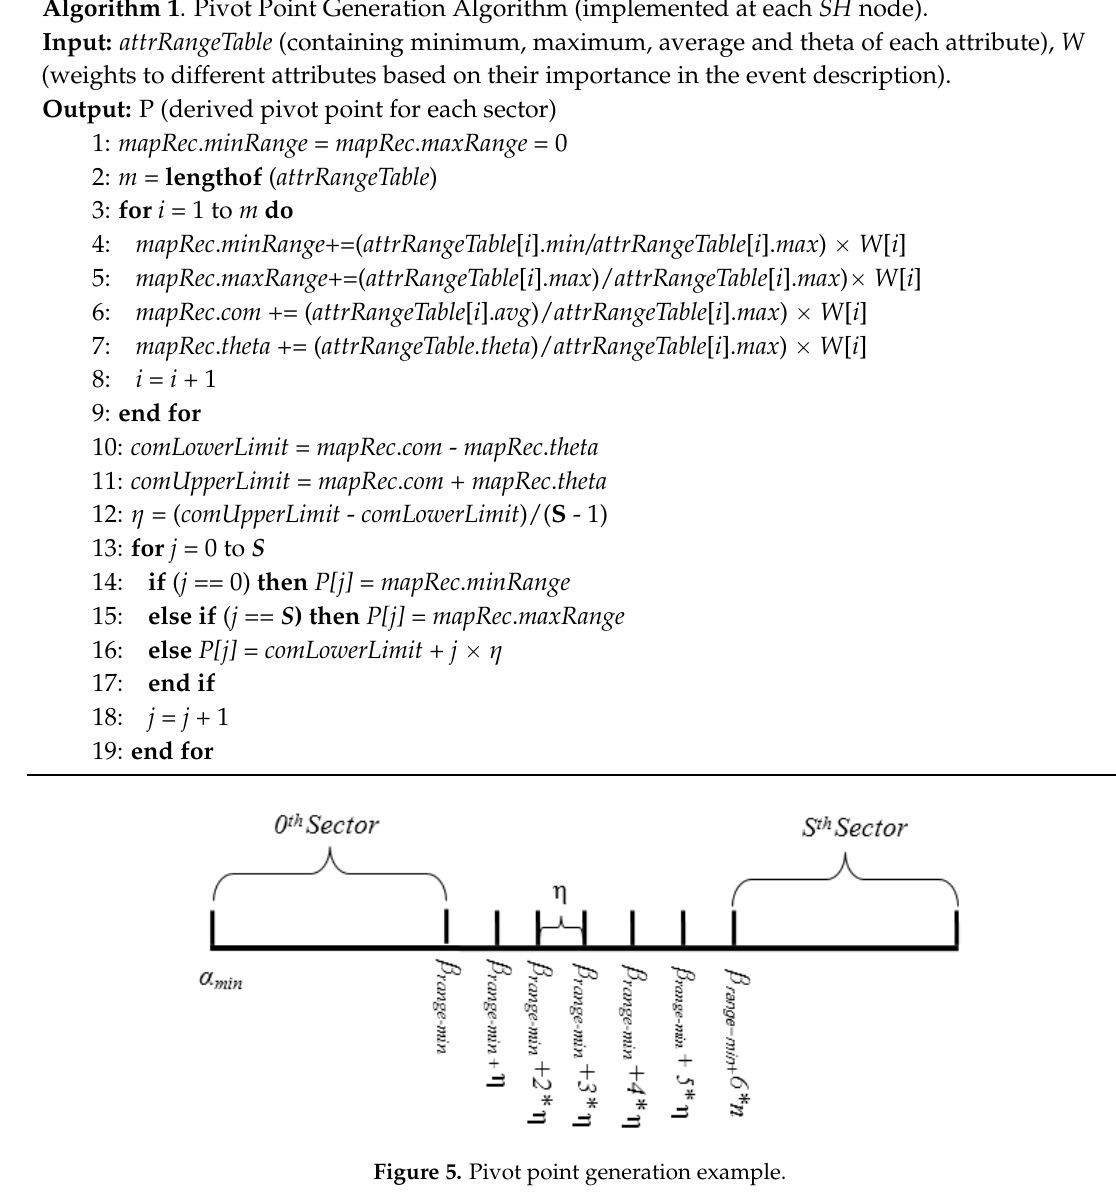
Algorithm 1 . Pivot Point Generation Algorithm (implemented at each SH node).